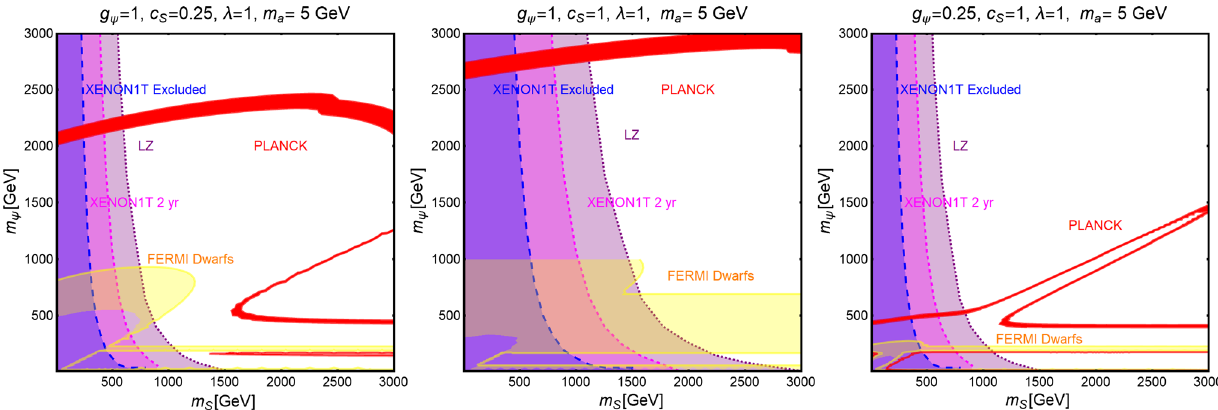
Fig. 20 Summary of constraints for the scalar + light pseudoscalar portal with a fermionic DM in the bi-dimensional plane ( m S , m ψ ) with m a , λ set to 5 GeV, 1, respectively. The three plots refer to the three assignations of ( g ψ , c S ) couplings as ( 1 , 0 . 25 ) (left), ( 1 , 1 ) (middle) and ( 0 . 25 , 1 ) (right). In each plot the red lines are the contours of the